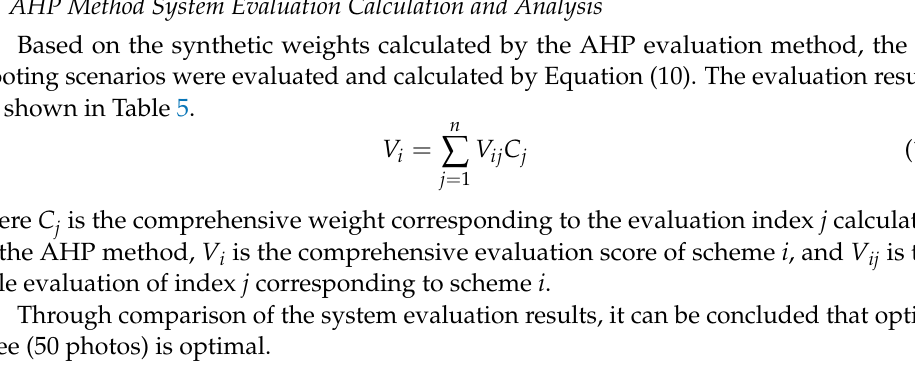
corresponding evaluation scores are shown in Table